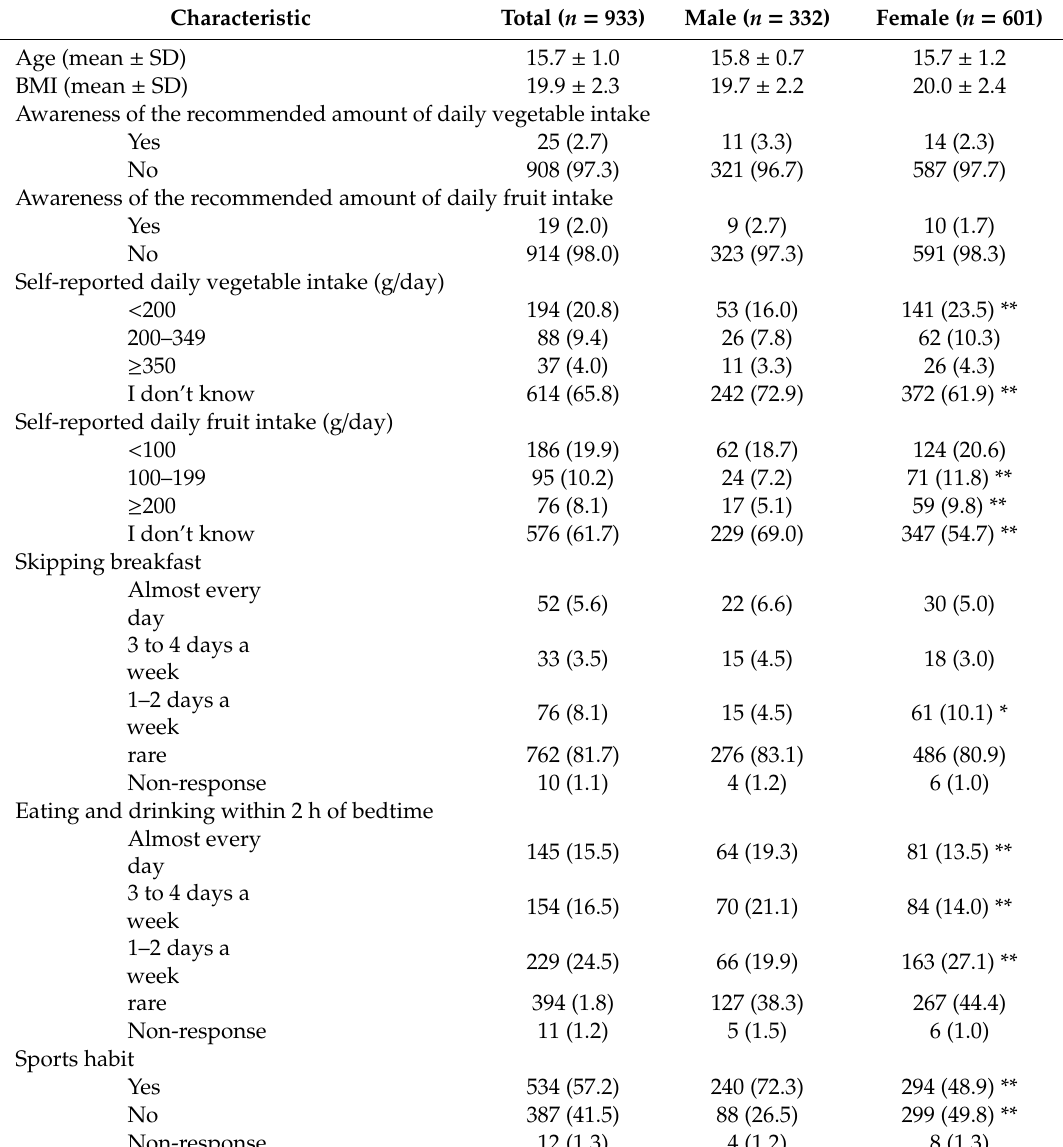
Table 1. Participants